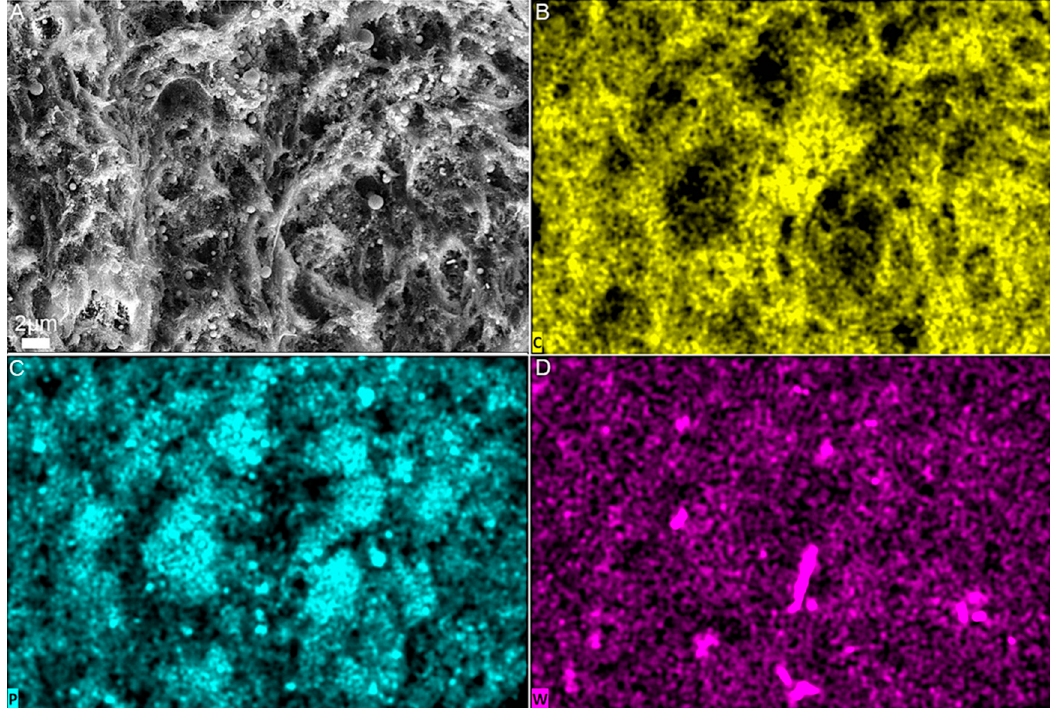
Figure 5. HR-SEM image of PLLA film reinforced with 40 wt% HA and 0.75 wt% INT-WS 2 in SE mode ( A ) and EDS elemental mapping of the same area: carbon ( B ), phosphorus ( C ), and tungsten ( D ).